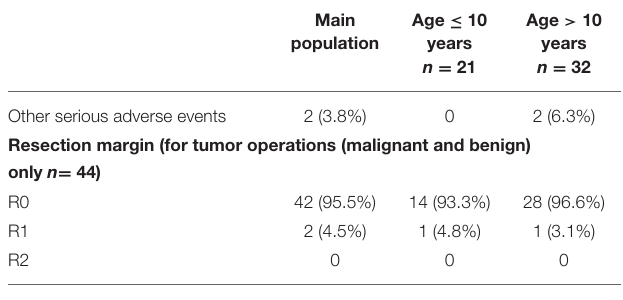
TABLE 4 | Multivariable regression analysis for the endpoint Textbook